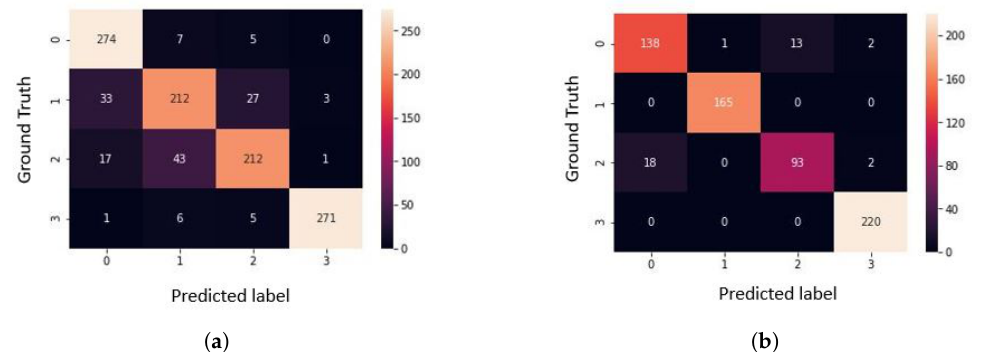
Figure 6. ( a ) Shallow VGG with RF on tomato diseases ( b ) Shallow VGG with Xgboost on corn.